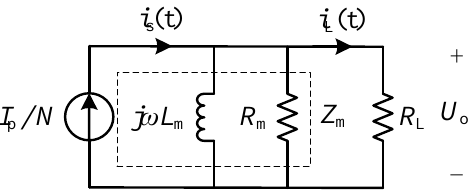
Figure 4. CT energy harvesting circuit without compensation.